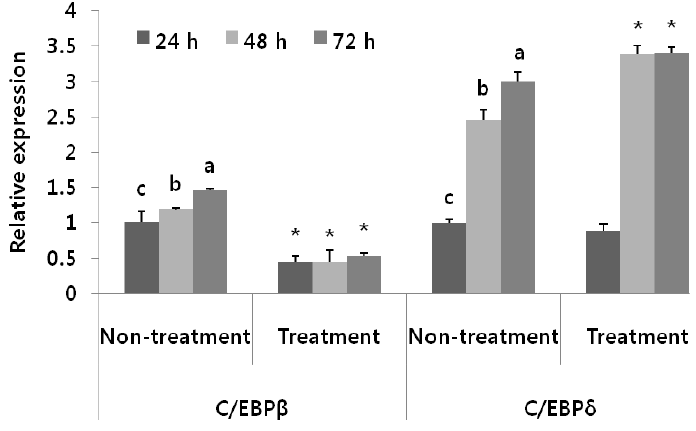
Figure 4. Effects of black adzuki bean on mRNA expression of the early transcription factors expressed during differentiation for the indicated periods. C/EBPβ and C/EBPδ mRNA expression was measured by qRT-PCR. The mRNA expression was normalized using β-actin and shown by relative expression compared to the untreated control group at 24 h. Data are expressed as means ± SD with different letters indicating a significant difference among the non-treatment control group, according to ANOVA with Duncan’s multiple range test ( p < 0.05) and treatment group compared with untreated (* p < 0.05) by Independent t